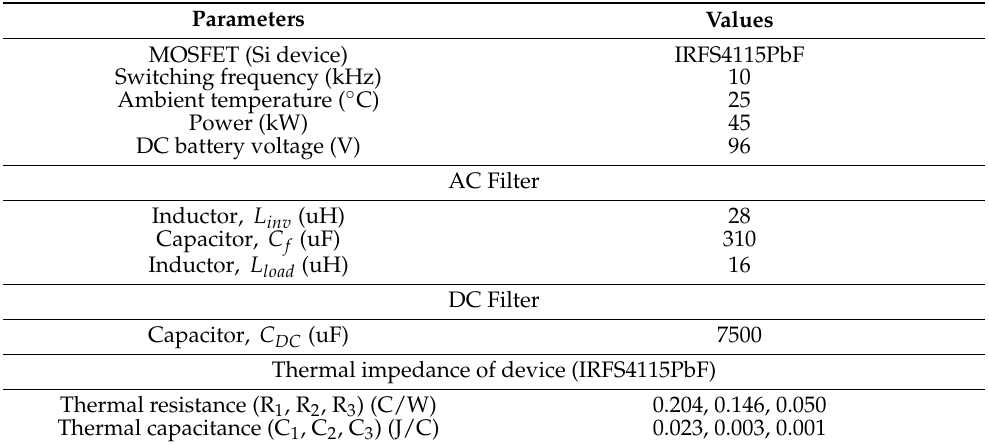
Table 1. Inverter parameters.